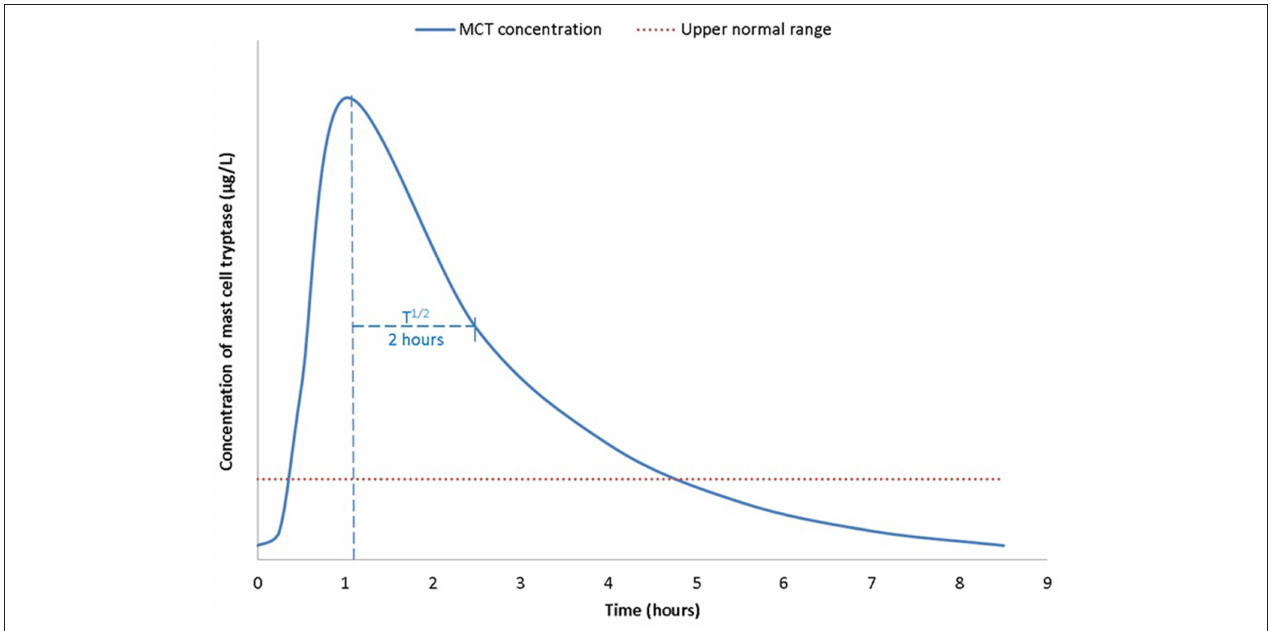
FIGURE 1 | Time kinetics of mast cell tryptase (MCT) during an anaphylactic reaction, from a baseline concentration (pre-reaction), MCT is rapidly released from mast cells and peaks ∼ 1–2h post allergen exposure. T 1 / 2 is ∼ 2h. Concentrations return to base line within 24h after complete resolution of symptoms and signs of